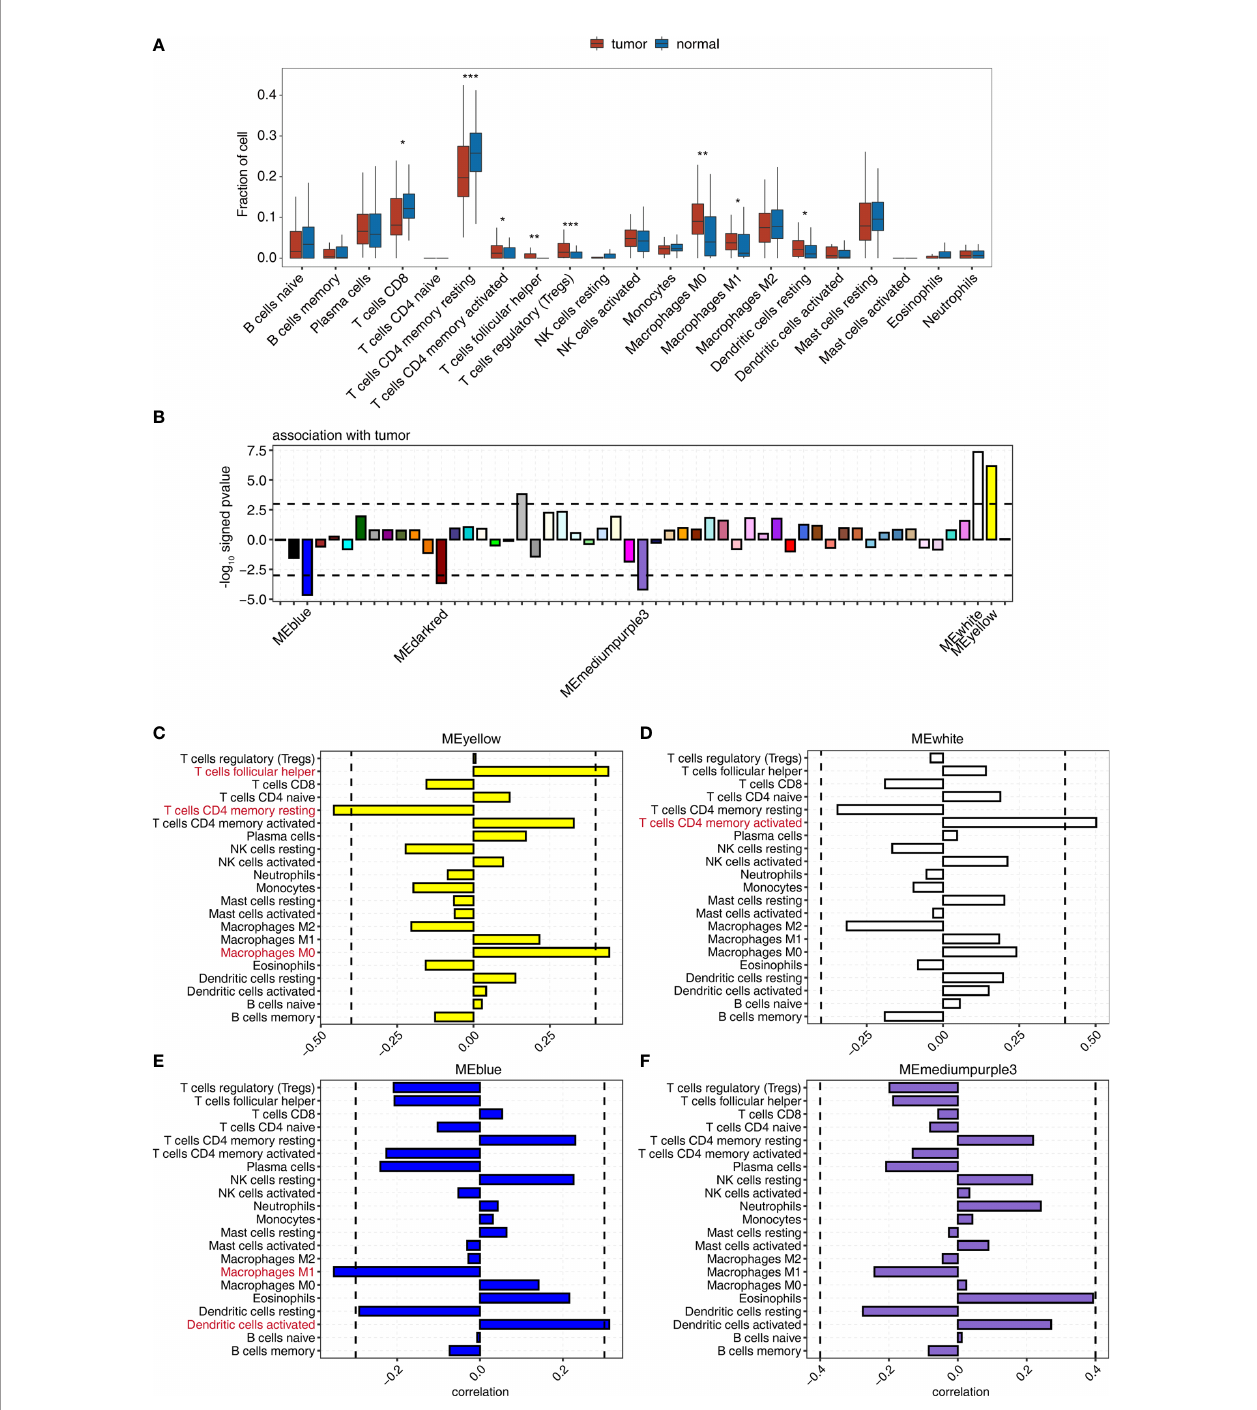
FIGURE 1 | WGCNA determination of the correlation between the expression of module eigengenes whose expression was tumor deregulated and the change in the proportion of tumor-associated immune cells. (A) Boxplot showing the fraction of each immune cell type in tumor or normal samples; the signi fi cant difference in the immune cell fractions between these two groups was calculated using the Student ’ s t -test. *pvalue ≤ 0.05; **pvalue ≤ 0.01; ***pvalue ≤ 0.001 (B) Signed association of the module eigengene expression with tumor. Positive values indicate modules with increased expression in tumor samples. Negative values indicate modules with decreased expression in tumor samples. Dashed lines signify tumor-associated modules. (C – F) Correlation between immune cell population and the expression of module eigengenes from (C) MEyellow, (D) MEwhite, (E) MEblue, and (F) MEmediumpurple3. Dashed lines signify tumor-associated